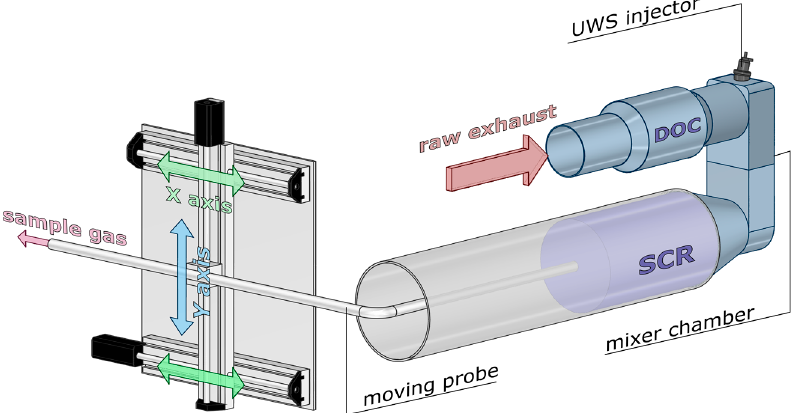
Figure 5. View of a modified SCR reactor and exhaust gas probing system for NH 3 and NO x uniformity measurement.